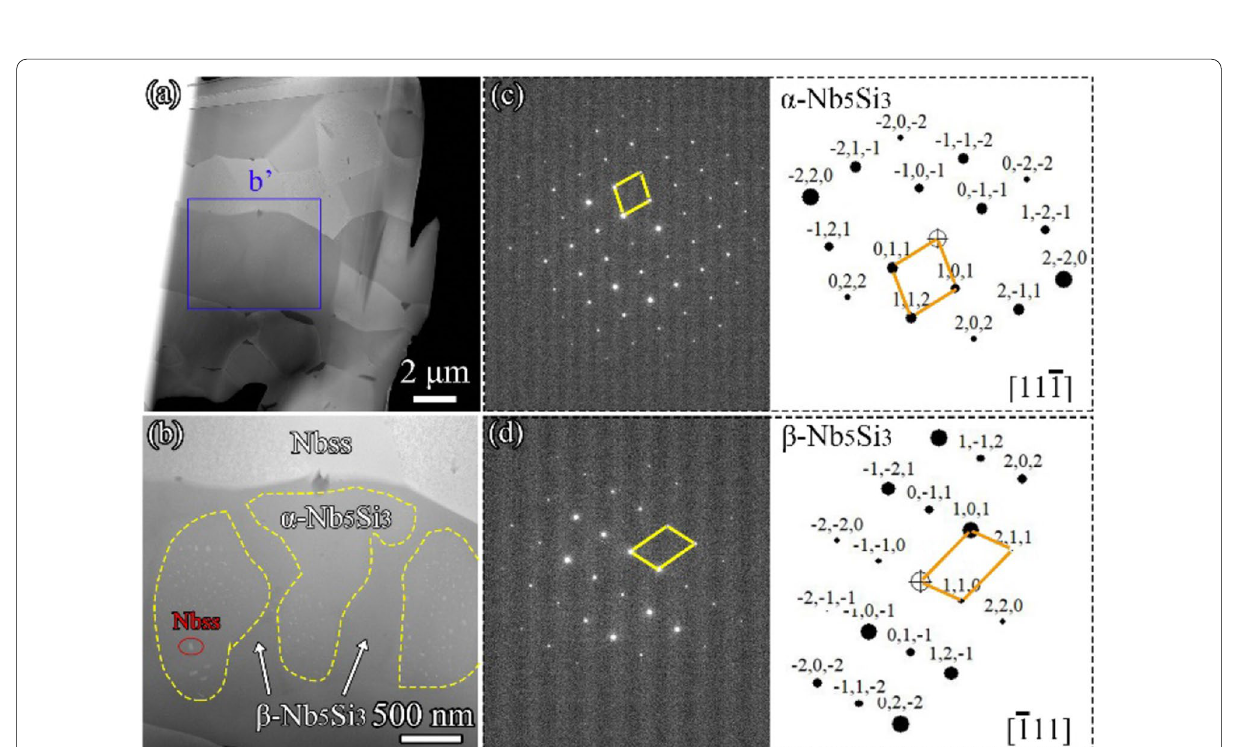
Figure 6 ( a , b ) HAADF-STEM images of the hypereutectic Nb-Si based alloy via EBSM after annealing treatment, ( c ) SAD patterns of α-Nb5Si3, ( d )